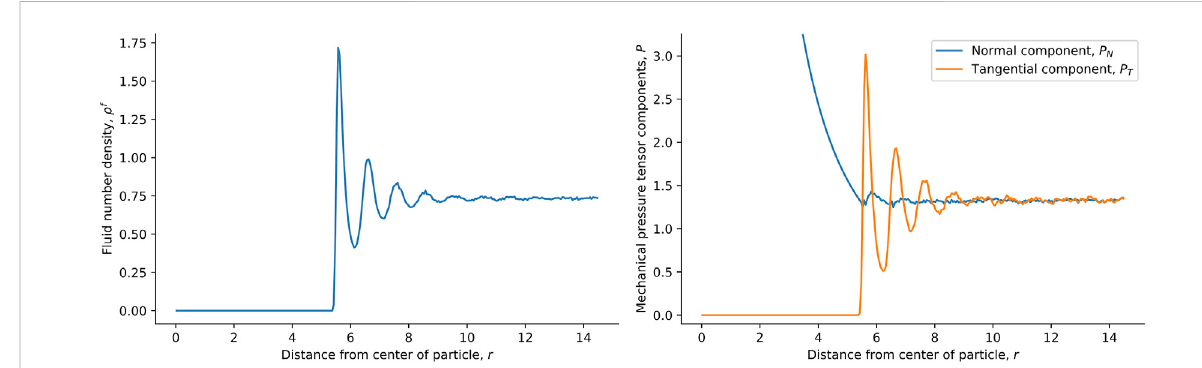
FIGURE 3 Local fl uid number density (left) and normal and tangential pressure tensor components (right) in spherical shells as a function of the distance from the center of the spherical particle in the single-sphere simulation case. The fl uid chemical potential is fi xed to μ f = 1 ζ and the particle radius is R = 5 σ .